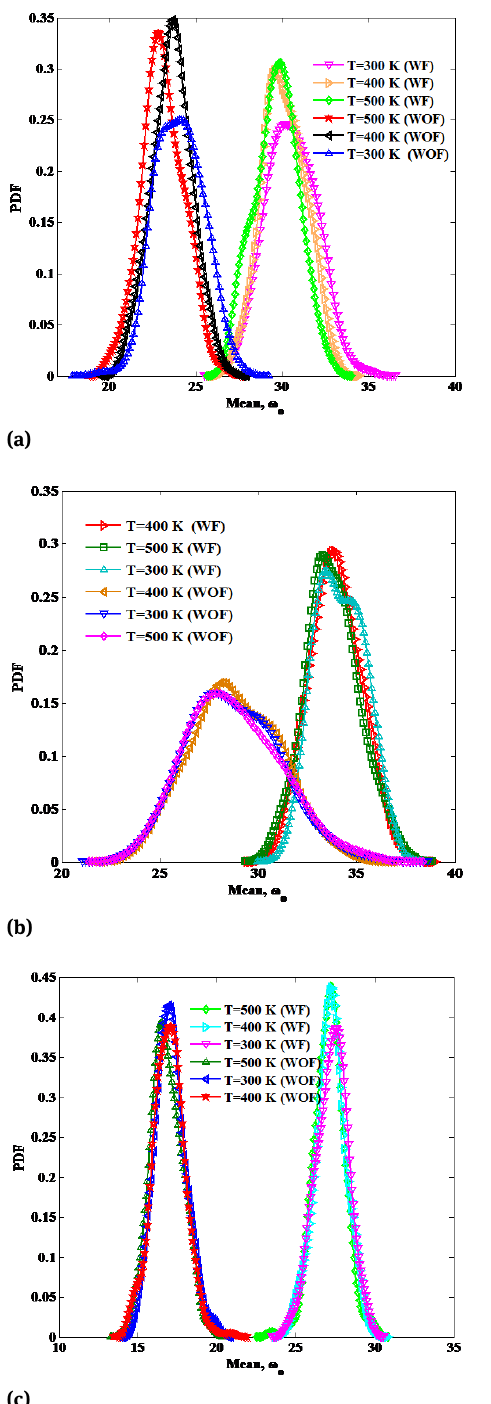
Figure 7: The effect of COC on the PDF of nonlinear fundamental frequency and combined random variables { b i ;( i = 1 to 16) = (0.05−0.20) } on COV with and without foundation for (a) UD and (b) FG-X and (c) FG- Λ distributed CNTRC beams at a / h = 25, W max/ h h = 1, V * cn = 0.28 , T = 300K, N = 10 4